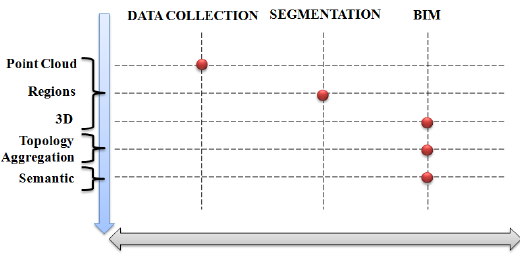
Figure 1: Process of BIM creation composed by complementary and consecutive tasks (collection, segmentation, BIM) in order to get point clouds, regions, 3D representation, relations and attributes